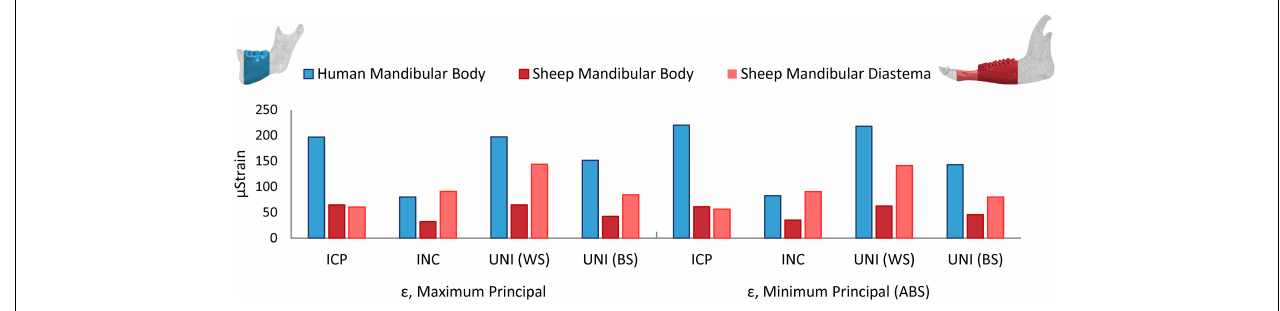
FIGURE 4 | Average maximum and minimum principal strains ( ε ) in the healthy human and sheep mandibular body, and in the sheep mandibular diastema, for the intercuspal (ICP), incisal (INC), and unilateral (UNI) clenching tasks, the latter in both working (WS) and balancing sides (BS).